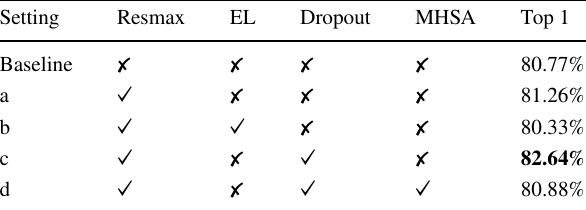
Table 2 Ablation experiment Setting